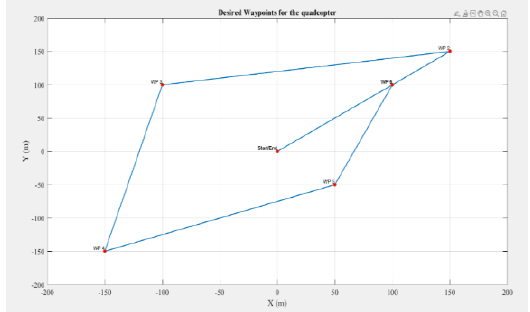
Figure 4. Waypoint flight